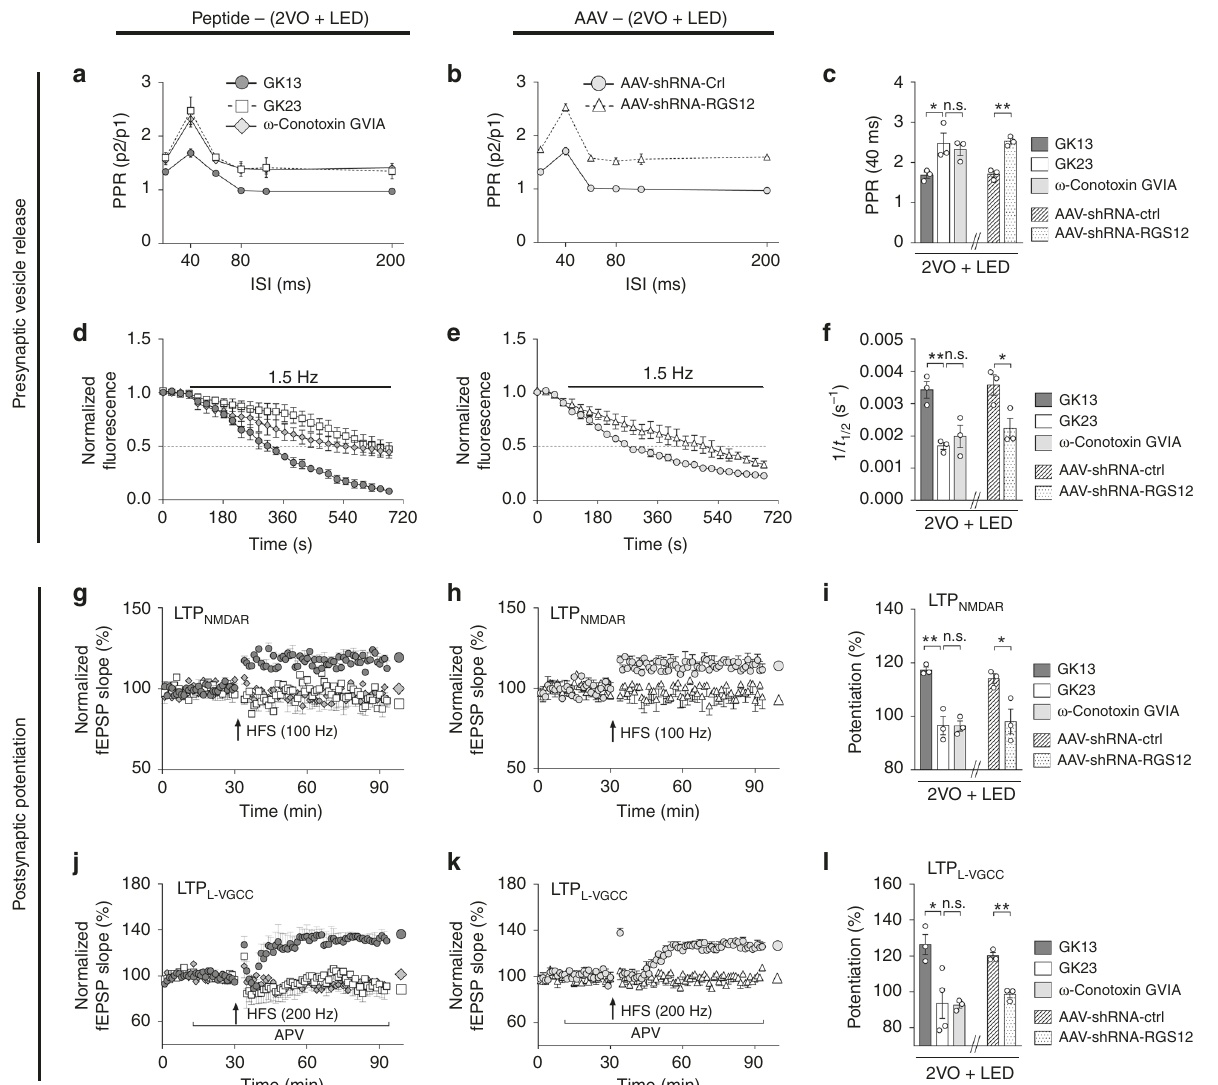
Fig. 8 RGS12 regulation of N-VGCC-dependent PPR, vesicle release, and LTPs. a Mouse was implanted with an osmotic pump delivering GK13, GK23, or ω -conotoxin GVIA before the 2VO surgery and 40 Hz light treatment throughout the 3 d periods. Hippocampal slices were subjected to PPR measurements. b AAV-shRNA-Ctl and AAV-shRNA-RGS12 were stereotaxic injected into the CA1 area for 3 weeks, followed by 2VO and 40 Hz light treatment (2VO + LED) for 3 d. Hippocampal slices were measured for PPR. PPR at the 40 ms ISIs for both a and b were measured and plotted in c . a , b , and c share the same legends ( n = 3 mice each group). The hippocampal brain slices of 2VO + LED mice treated either with GK13, GK23, and ω -conotoxin GVIA ( d ) or with AAV-shRNA-Ctl and AAV-shRNA-RGS12 ( e ) were measured for presynaptic vesicle release probability based on the kinetics of FM1-43 release from presynaptic terminals. Rate (1/t 1/2 ) of puncta unloading in brain slices was plotted and shown in f . d , e , and f share the same legend ( n = 3 mice each group): g – l Measurements of LTPs. The effect of osmotic pump application of RGS12 decoy peptide GK23 ( g , i , j , l ) and AAV-shRNA-RGS12 ( h , i , k , l ) on CA3-CA1 LTPs of 2VO mice 3 d after 40 Hz light treatment (2VO + LED) was determined using 100 Hz ( g , h ) or 200 Hz ( j , k ) tetanic stimulations ( g – l n = 3 mice in all groups except n = 4 mice in LTP L-VGCC GK 23 group). Data represent the mean ± SEM. Error bars indicate SEM. * P < 0.05, ** P < 0.01. The test used on the left side of c , f , i , l 1ANOVA with Dunnett ’ s post hoc test; on the right side of c , f , i , l Two-tailed unpaired t-test; g , h , j , k RM-2ANOVA with Sidak ’ s post hoc test. Source data are provided as a Source Data fi light treatment. The shapes of individual dendritic spines are Microglia activation in cerebral ischemia can be either bene- fi cial or detrimental to neurons depending on the timing. proposed to correlate with their capacity for structural changes. In particular, the stubby and mushroom-shaped boutons located Although 40 Hz light activates microglia in Alzheimer ’ s disease on CA1 apical dendrites were accounted for 90% of the increased mouse brain to clear β -amyloids 10,11 , the current data failed to indicate microglia response to light fl icker in the ischemia brain. boutons. These two types of boutons are spines that endure This is based on microglia immunostaining and the lack of structural modi fi cations resulting in enhanced LTPs. CA3 spine microglia-related gene expression in proteomic pro fi ling. The losses at 7 d and 14 d post-2VO were rescued by light fl icker light treatment time may underlie the lack of response of treatment supporting the role of light fl icker in the strengthening microglia in the current 2VO studies. of CA3-CA1 synaptic connections.